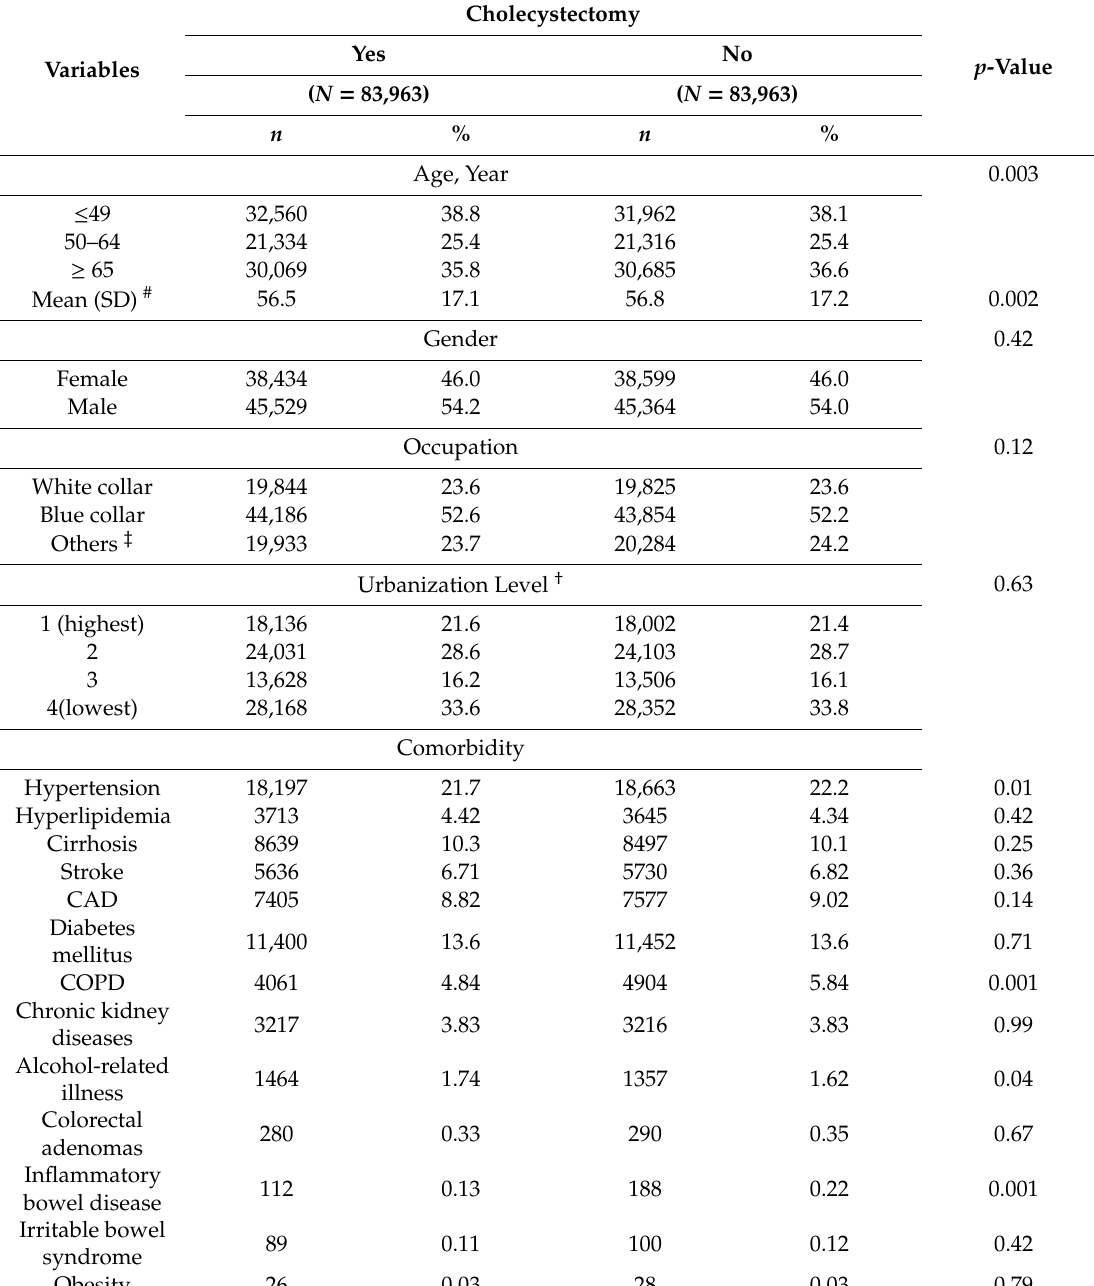
Table 1. Characteristics of patients between gallbladder stones patients with cholecystectomy and without